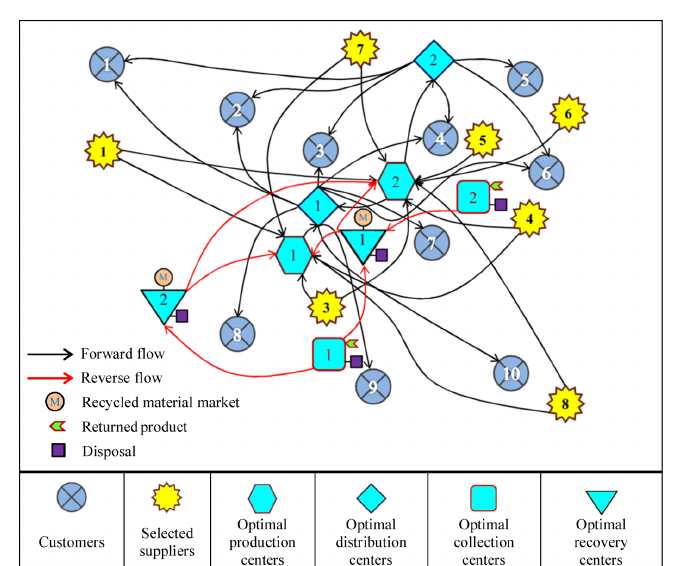
Fig 5. The optimal network design with a = 0.5 and w c = w g =